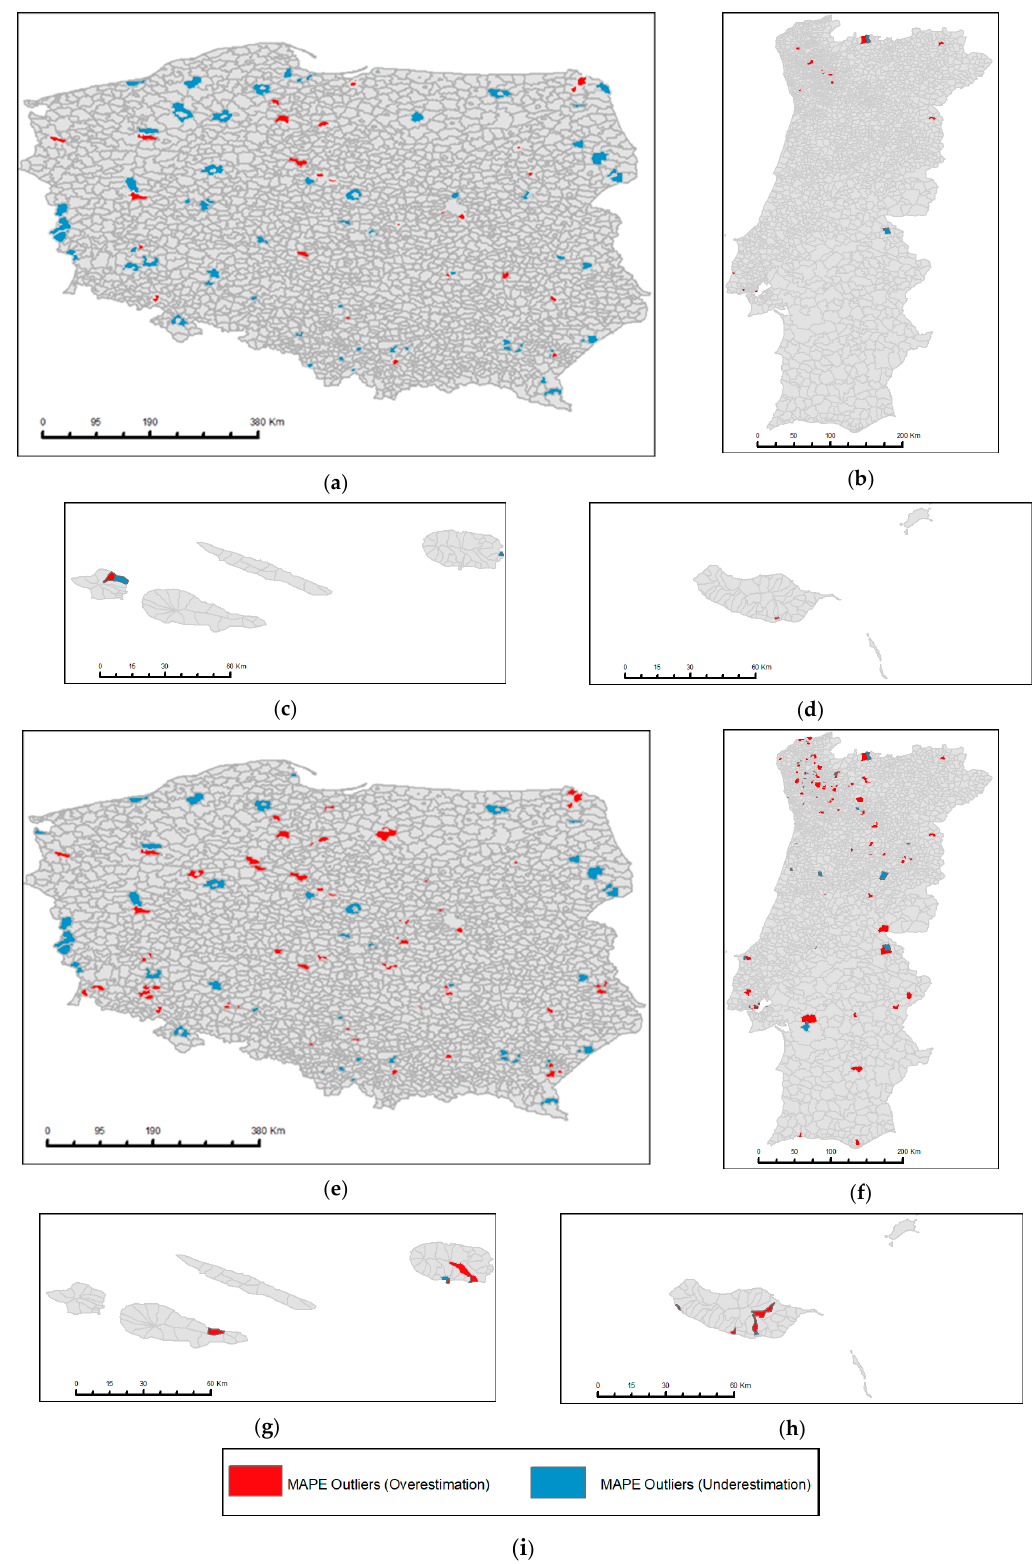
Figure 14. Extreme outliers of MAPE. ( a ) 250 m grid cells, Poland; ( b ) 250 m grid cells, Portugal; ( c ) 250 m grid cells, Azores; ( d ) 250 grid cells, Madeira; ( f ) 1 km grid cells, Poland; ( g ) 1 km grid cells, Portugal; ( h ) 1 km grid cells, Azores; ( i ) 1 km grid cells, Madeira; ( j ) legend.